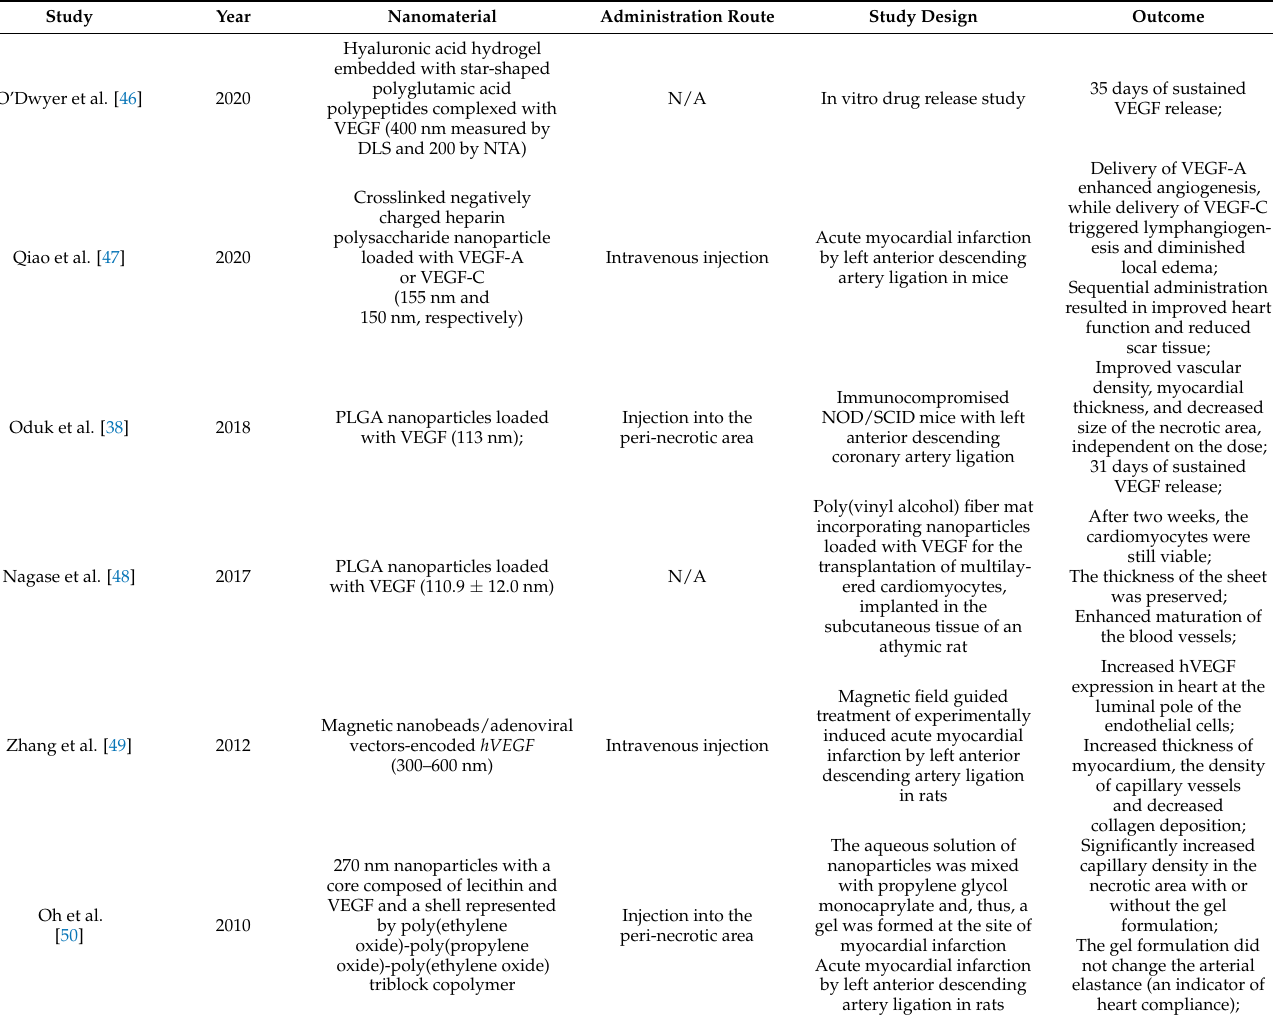
Table 1. VEGF delivery by